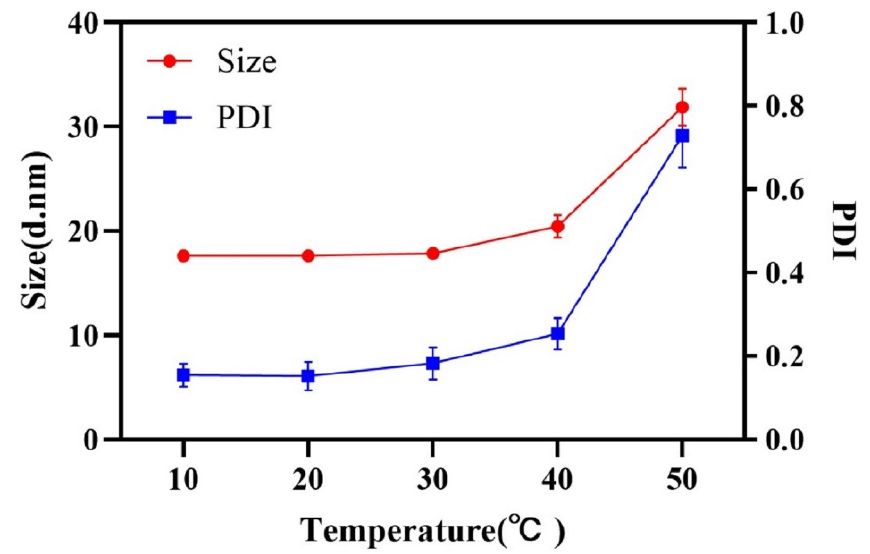
Figure 3. Droplet size and PDI at different emulsification